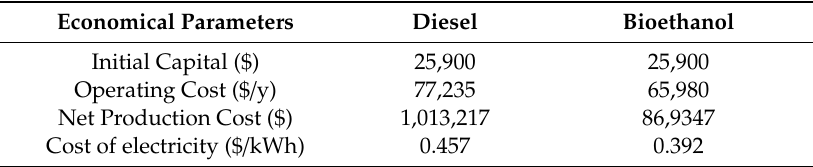
Table 7. Economical parameters after result simulation for the proposed Table 6. Fuel properties of diesel and bioethanol.